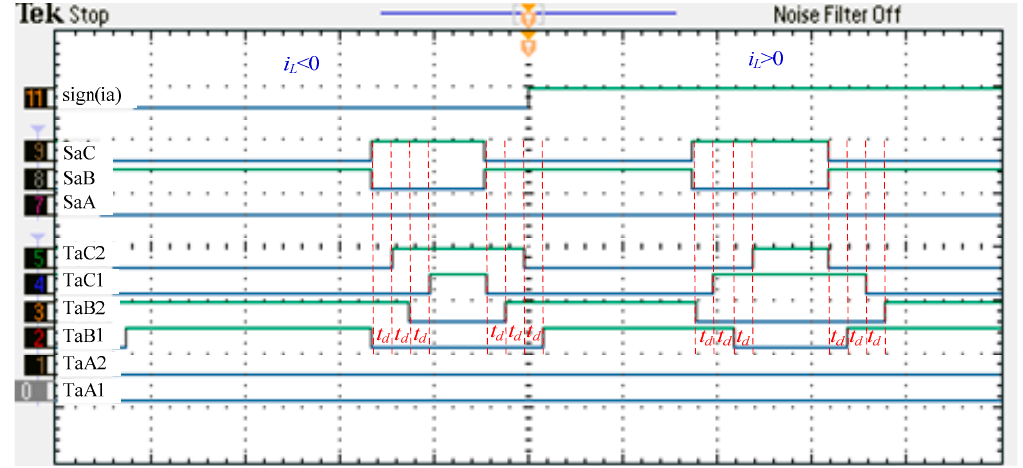
Figure 9. The measurement of control signals for output phase “a”.